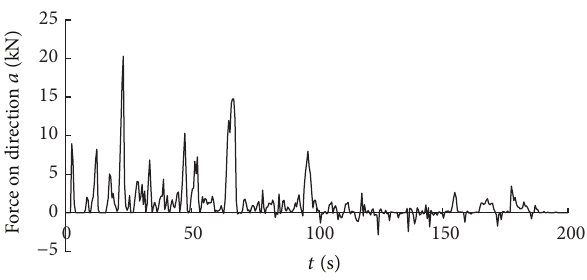
Figure 11: Time history curve of the force on direction 𝑎 on cutting head.